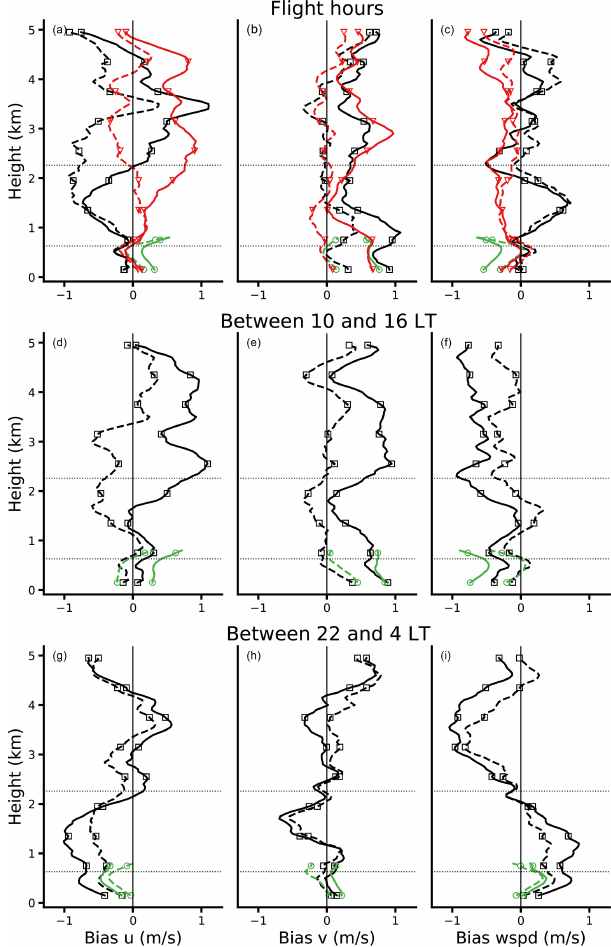
Figure 12. Mean model bias (forecast in solid and ERA5 in dashed) during flight hours (a–c) and during the whole EUREC 4 A campaign, measured separately for daytime between 10:00 and 16:00LT (d–f) and for nighttime between 22:00 and 04:00LT (g–i) . The bias is calculated with respect to radiosondes (black squares), lidar measurements (green circles), and dropsondes (red triangles). From left to right the columns refer to the bias in the zonal wind ( u ), meridional wind ( v ), and wind speed.